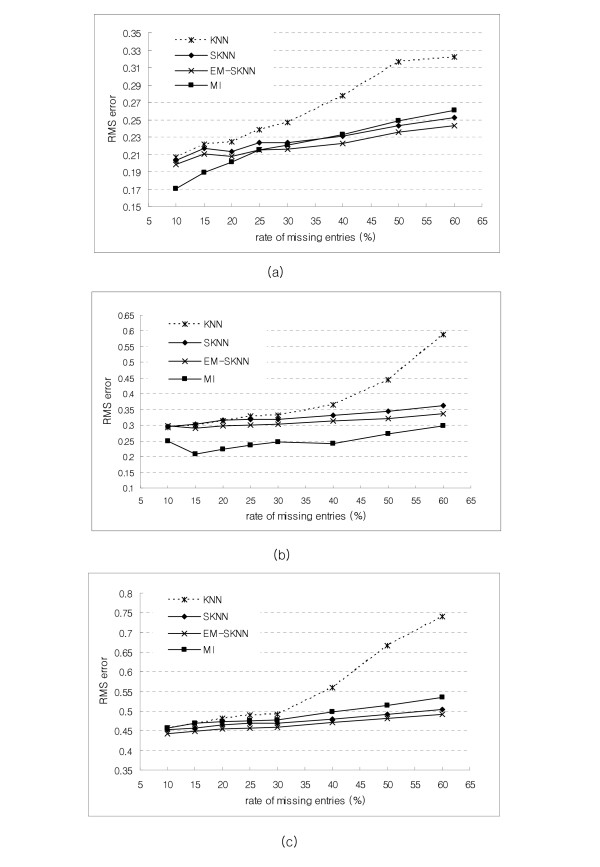
Comparison of the accuracy of KNN, sequential KNN, EM style sequential KNN, and MI methods for three different types of data sets. The accuracies were assessed by Root Mean Squared (RMS) error. Tested data sets were time series data set [22] (a), mixed (time series and non-time series) data set [23] (b), and non-time series data set [9] (c).